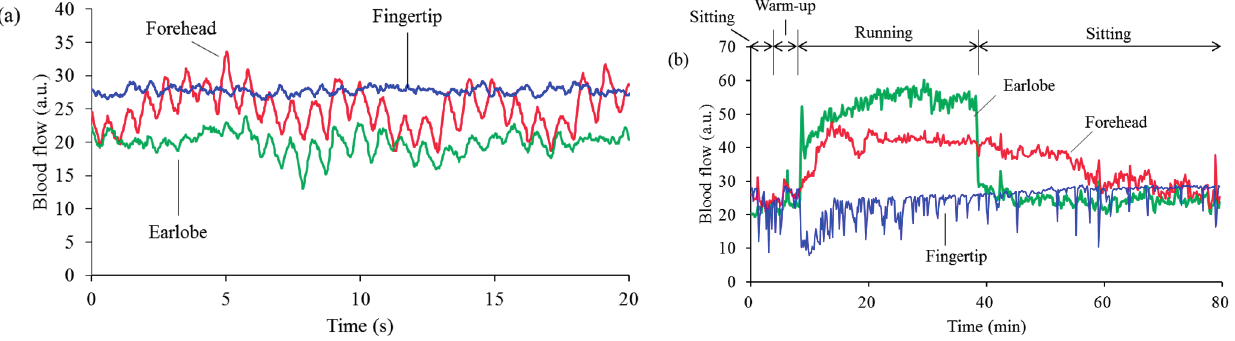
Figure 4. Differences in blood flow between measurement sites. Typical examples of basal blood flow in a sitting condition, before walking ( a ); and blood flow while the subject was running at 10 km/h ( b ) at the fingertip (blue), at the forehead (red), and at the earlobe